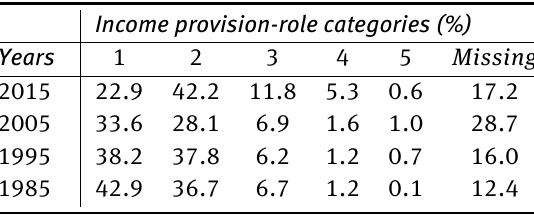
Table 1: Observed and missing frequencies of the couple’s income provision-role type (weighted with survey weights for years 2015 and 2005): (1) husband sole provider, (2) husband provides majority, (3) equal providers, (4) wife provides majority, (5) wife sole provider.